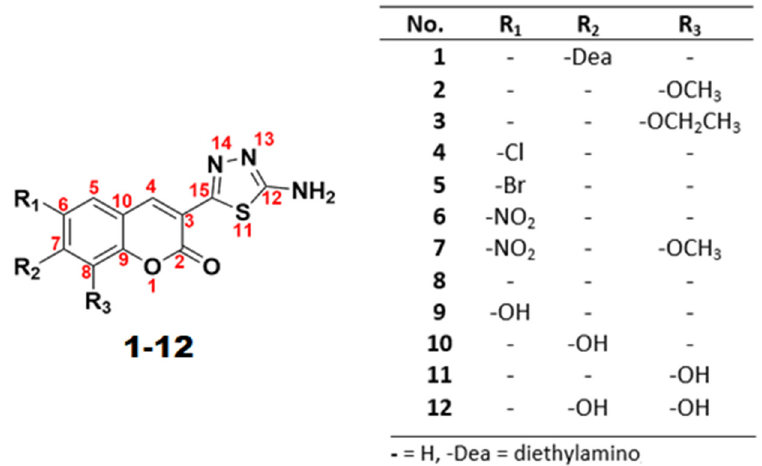
Figure 1. General structure of coumarin–thiadiazole hybrids 1-12 showing the numbering system of atoms and substituents present at the coumarin phenyl ring.